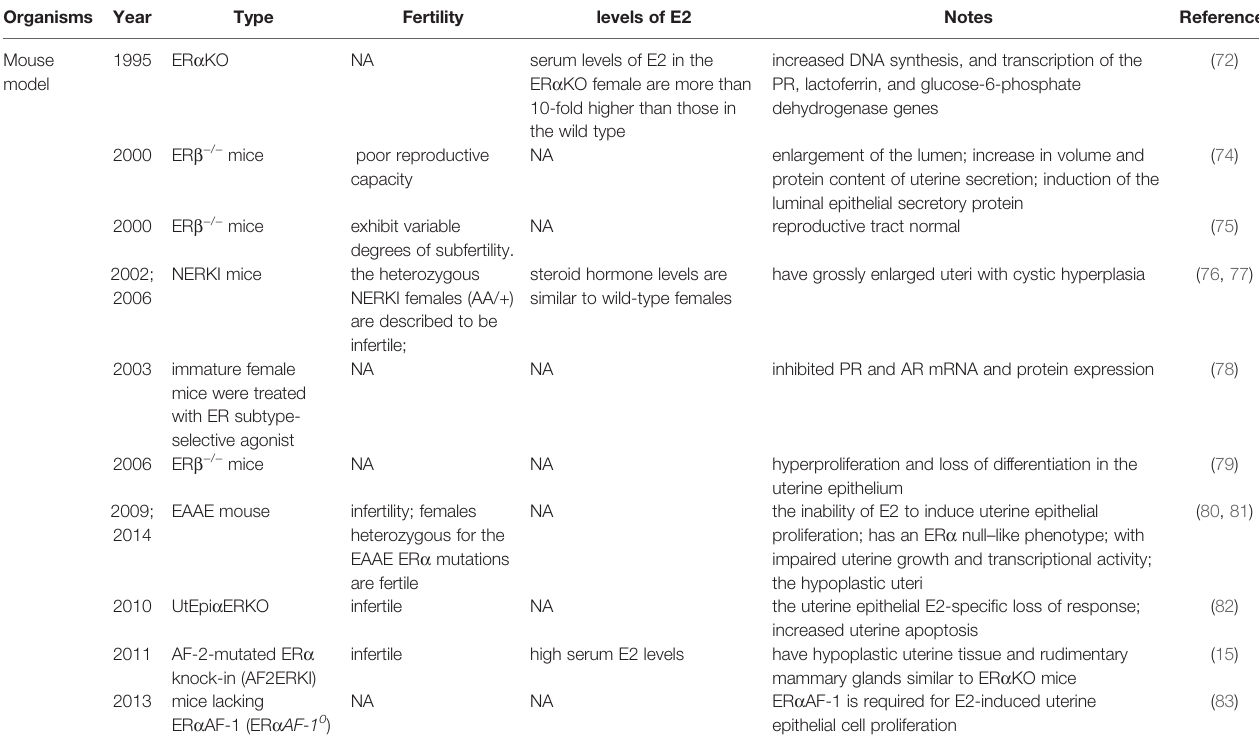
TABLE 2 | Summary of mouse models involving ER a and ER b